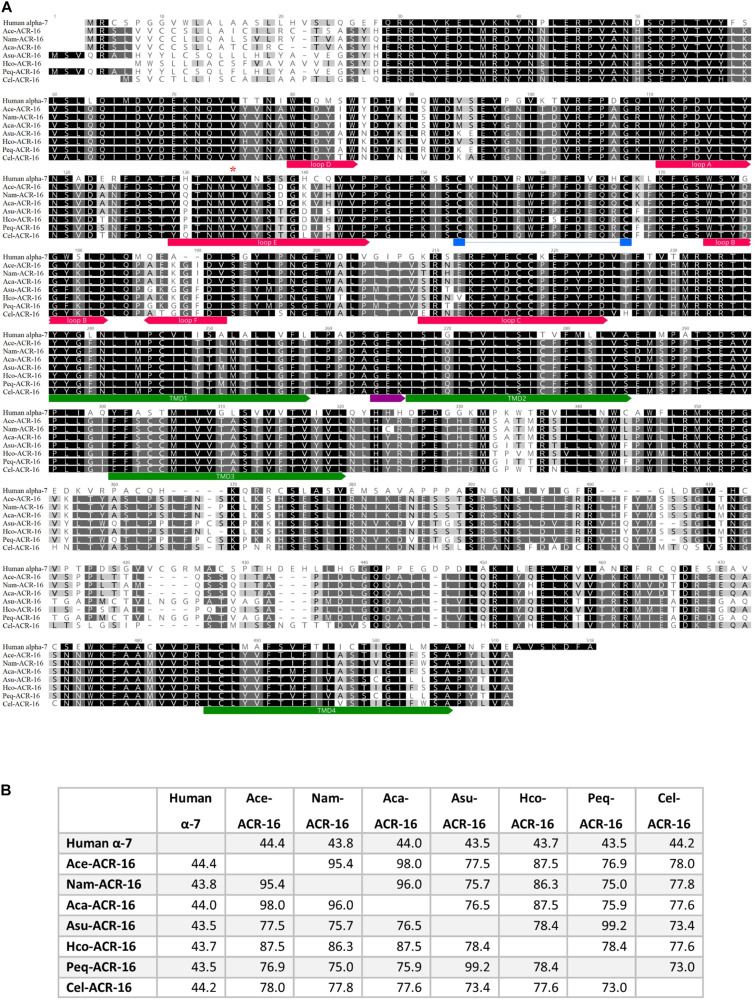
(A) Sequence alignment of ACR-16 from Ancylostoma ceylanicum (accession # MT163735), Necator americanus (accession # MT163736) Ancylostoma caninum (accession # QEM53385.1), Caenorhabditis elegans (accession # CCD64102.1), Haemonchus contortus (accession # AZS27833.1), Ascaris suum (accession # KP756901), Parascaris equorum (accession # AZS27834.1), and the human α7 acetylcholine receptor subunit (accession # P36544.5). Amino acids are shaded by consensus sequence similarity; black is most, and white is least similar. The ECD ligand binding loops A-E are denoted in red, the characteristics cys-loop is indicated in blue, the cation selectivity motif is shown in purple and the transmembrane domains are in green. Red star indicates site of Ile130 of Nam-ACR-16 (B)% Identity matrix of the polypeptide sequences for comparison.